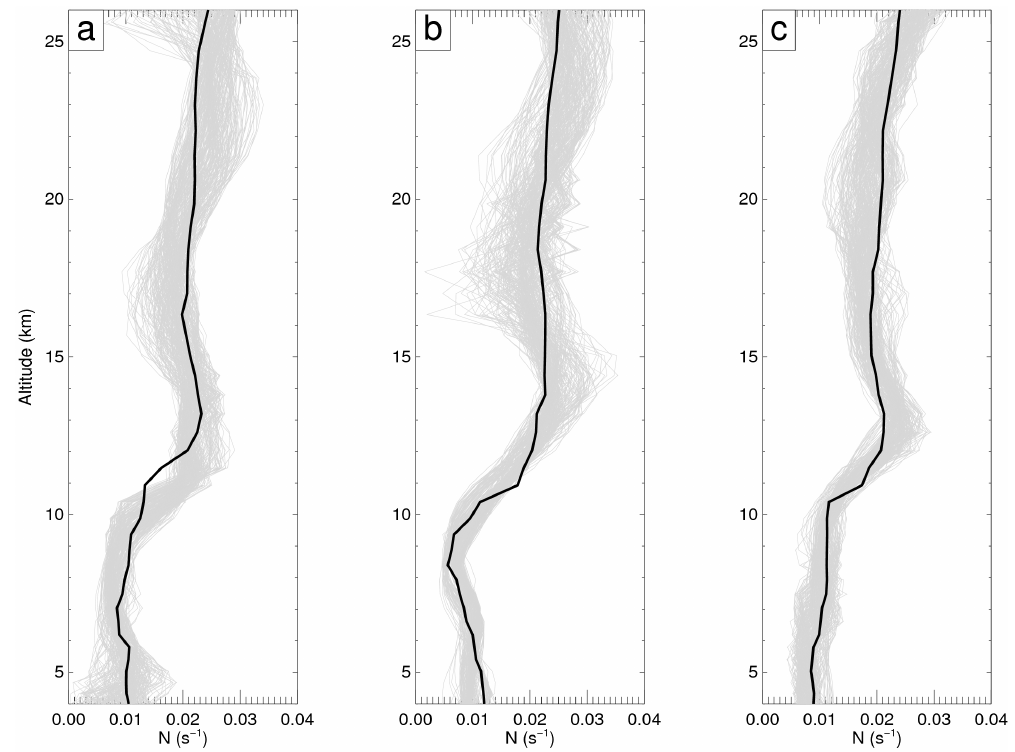
Figure 8. As Fig. 7, but for Brunt–Väisälä frequency N (s − 1 )